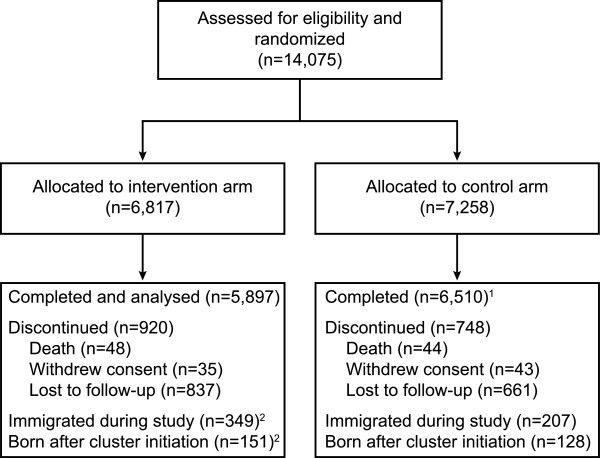
Consort chart. 1RDT was not done for subjects in the control arm and participants were excluded from the analysis. 2Not included in analysis as assessment was done after third campaign.